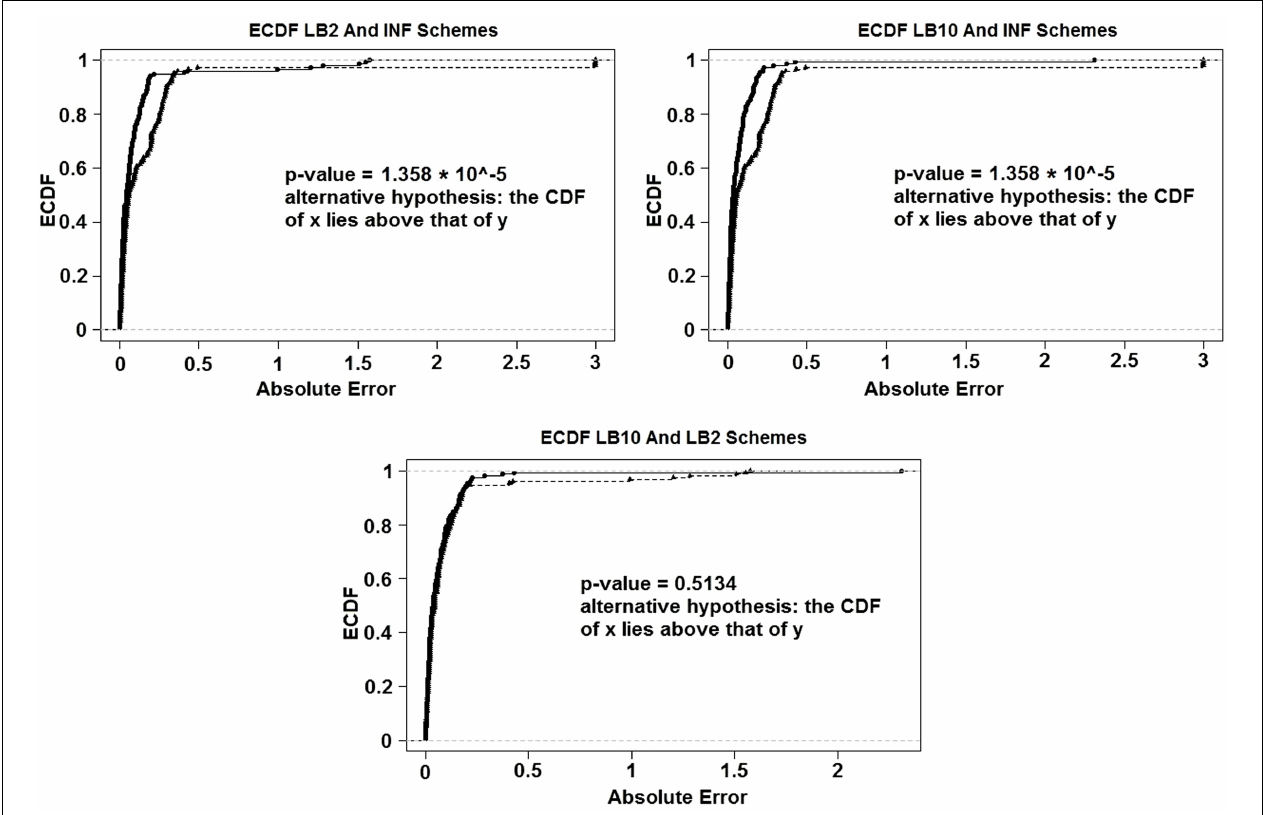
FIGURE 14 | ECDFs of the absolute errors of the parameter estimation . Top left – ECDFs for LB2 and INF, top right – ECDFs for LB10 and INF, and bottom – ECDFs for LB10 and LB2. Included are the p-values for 2-sample, 1-sided Kolmogorov–Smirnov tests. For definitions, see Tables 3 and 4 . Figure reconstructed from Macdonald and Husmeier